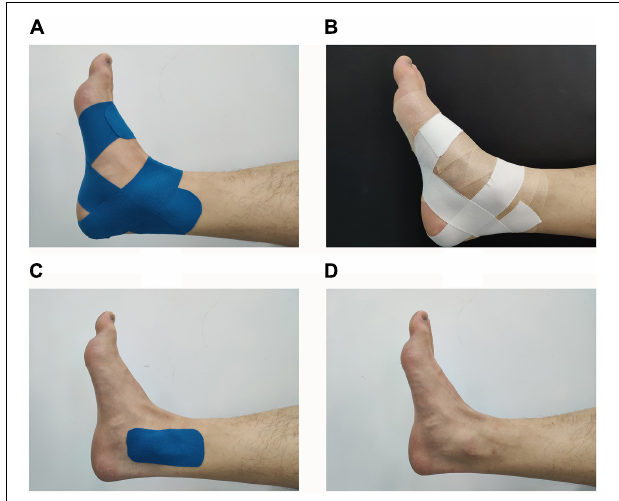
FIGURE 1 | Four different ankle taping treatments. (A) KT, kinesiology taping; (B) AT, athletic taping; (C) ST, sham taping; (D) NT, no taping.